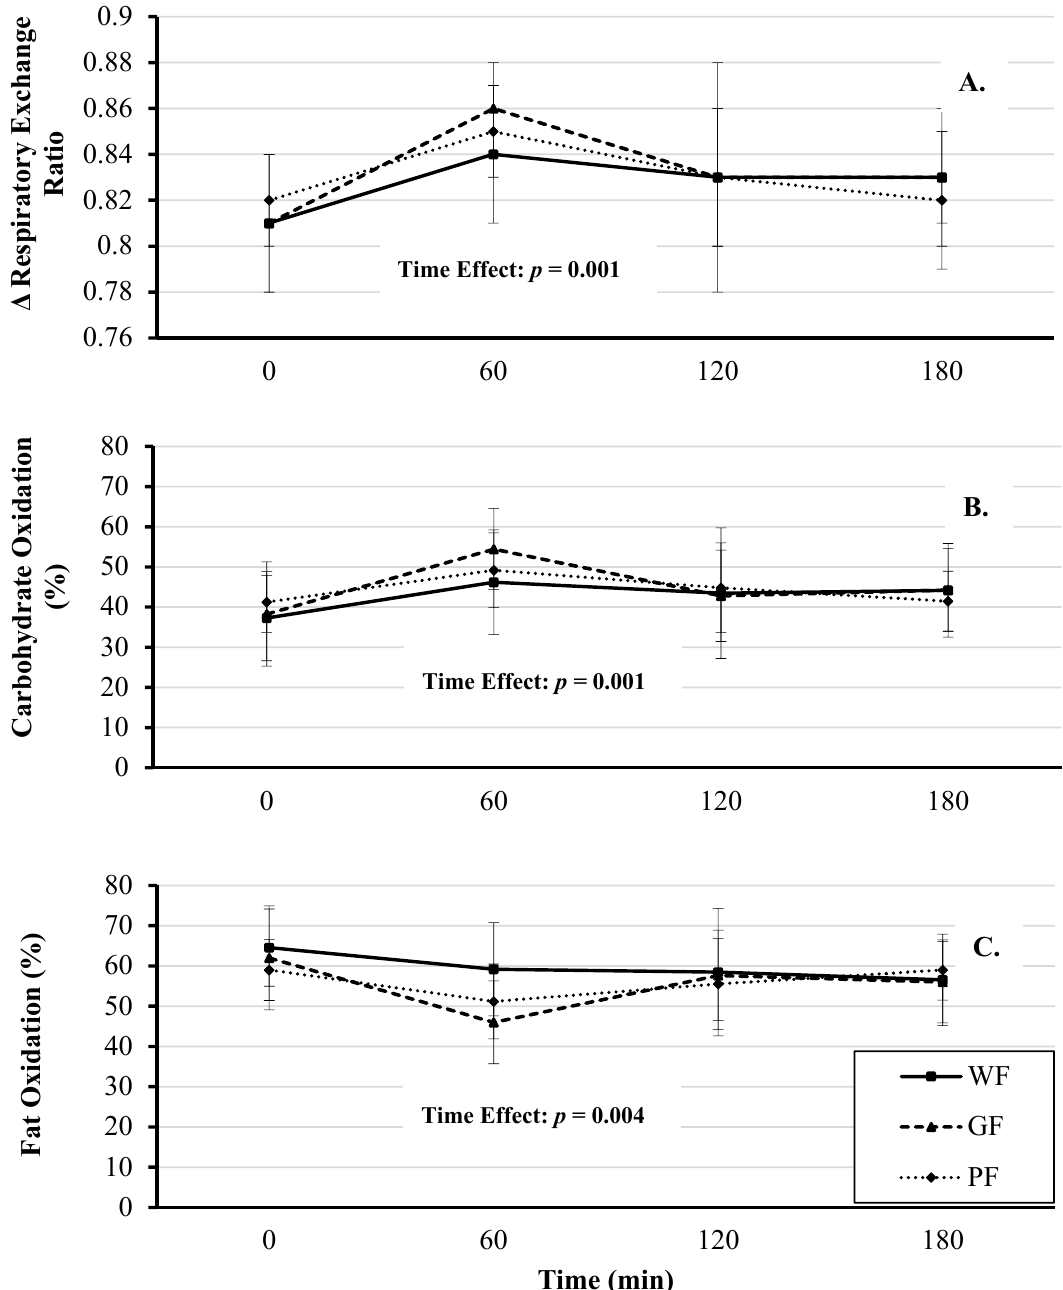
Figure 4. Comparison of respiratory exchange ratio (Panel A ), carbohydrate (Panel B ), and fat (Panel C ) oxidation responses after the consumption of whole foods (WF), gluten-free (GF) and processed (PF) meals. Significant time effect for all three conditions ( p < 0.05). Values are displayed as means ±95% confidence intervals.